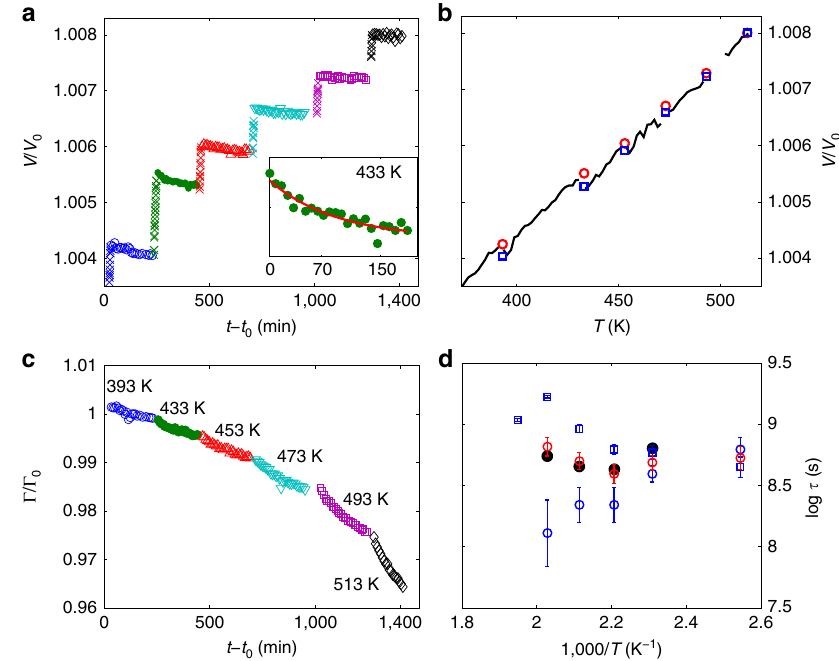
Figure 4 | Aging, volume reduction and medium range ordering. ( a ) Relative volume change (see text) reported as a function of t (cid:2) t 0 . Each temperature ramp (crosses) is followed by an isotherm. Symbols are as in Fig. 1. Inset: zoom of data at 433K reported as a function of time from the beginning of the isotherm, together with the best fit to an exponential law. ( b ) Relative volume change as a function of temperature. Lines: temperature ramps; empty circles and empty squares: first and last point of an isotherm, respectively. For a better visibility, we plot only data for T Z 373K. ( c ) Temporal evolution of the relative change of the width of the FSDP. ( d ) Characteristic time for aging as obtained from the volume relaxation ( t V , blue empty squares), the narrowing of the FSDP ( t G , blue empty circles) and from XPCS data ( t *, black full dots). The average of t V and t G is also reported (red empty circles). Error bars correspond to the error of the fitting procedure and to error propagation for the average of t V and t G . Where not shown, error bars are within the symbol size.